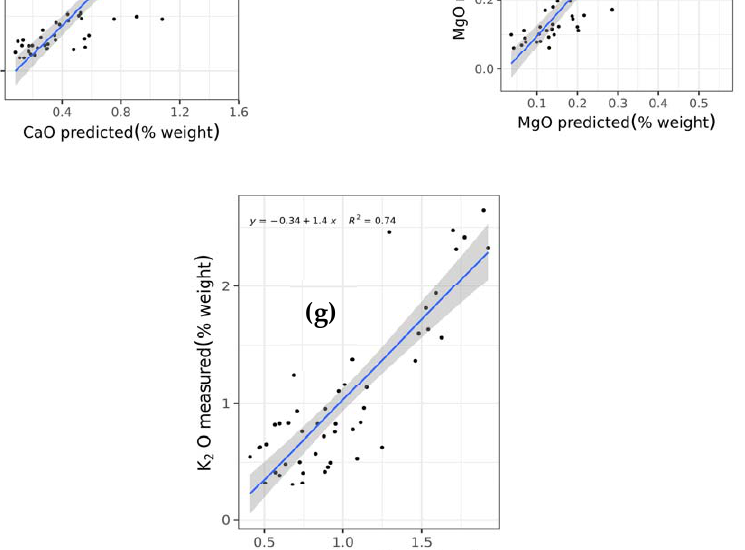
total nitrogen (N), ( d ) P 2 O 5 , ( e ) CaO, ( f ) MgO, and ( g ) K 2 O using the stacked regression ensemble approach.